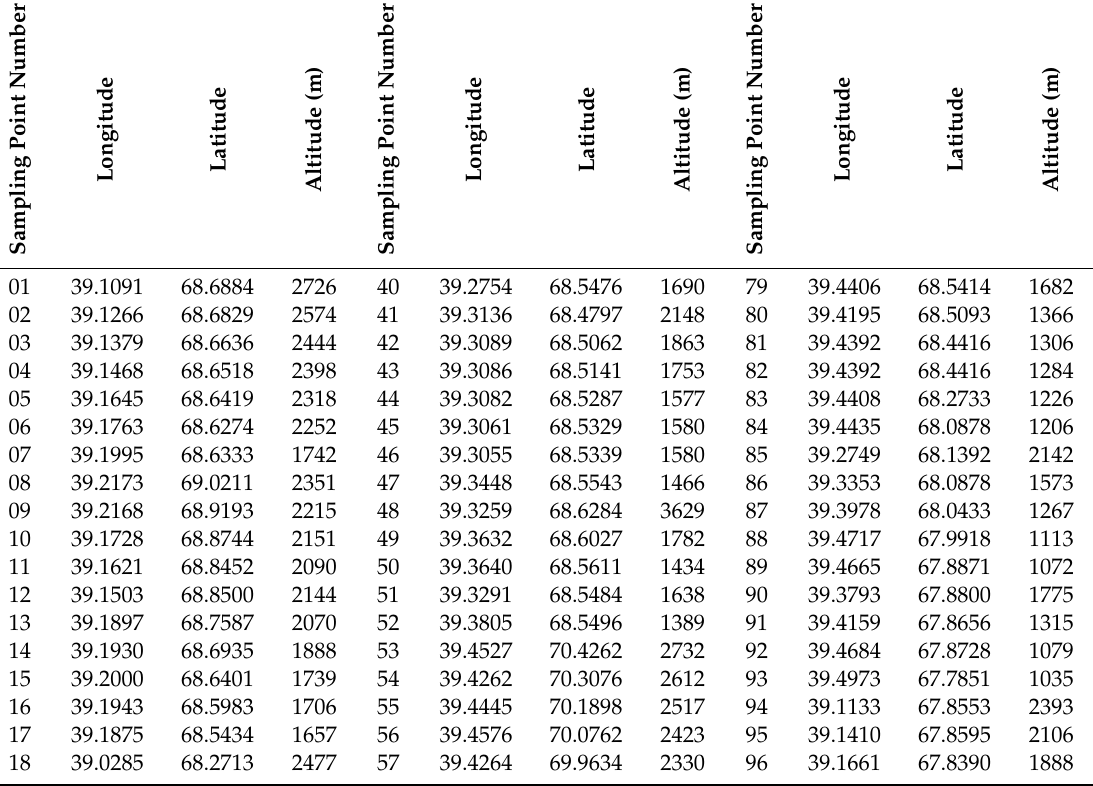
Table 1. Geographical coordinates of sampling